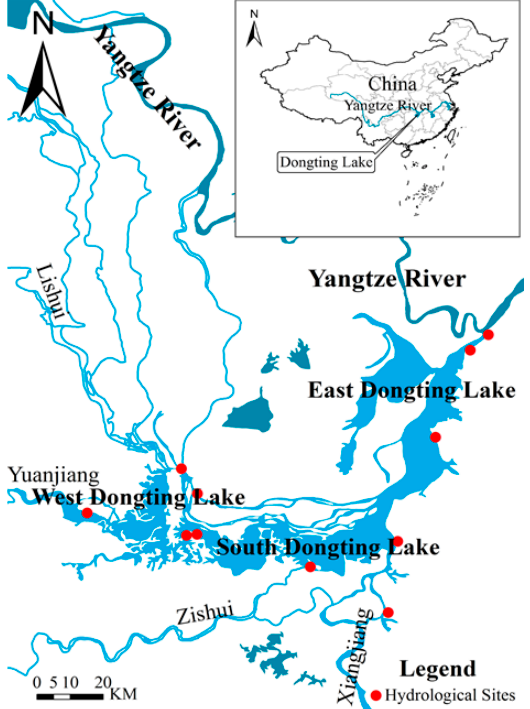
Figure 1. Study area and distribution of hydrological stations.